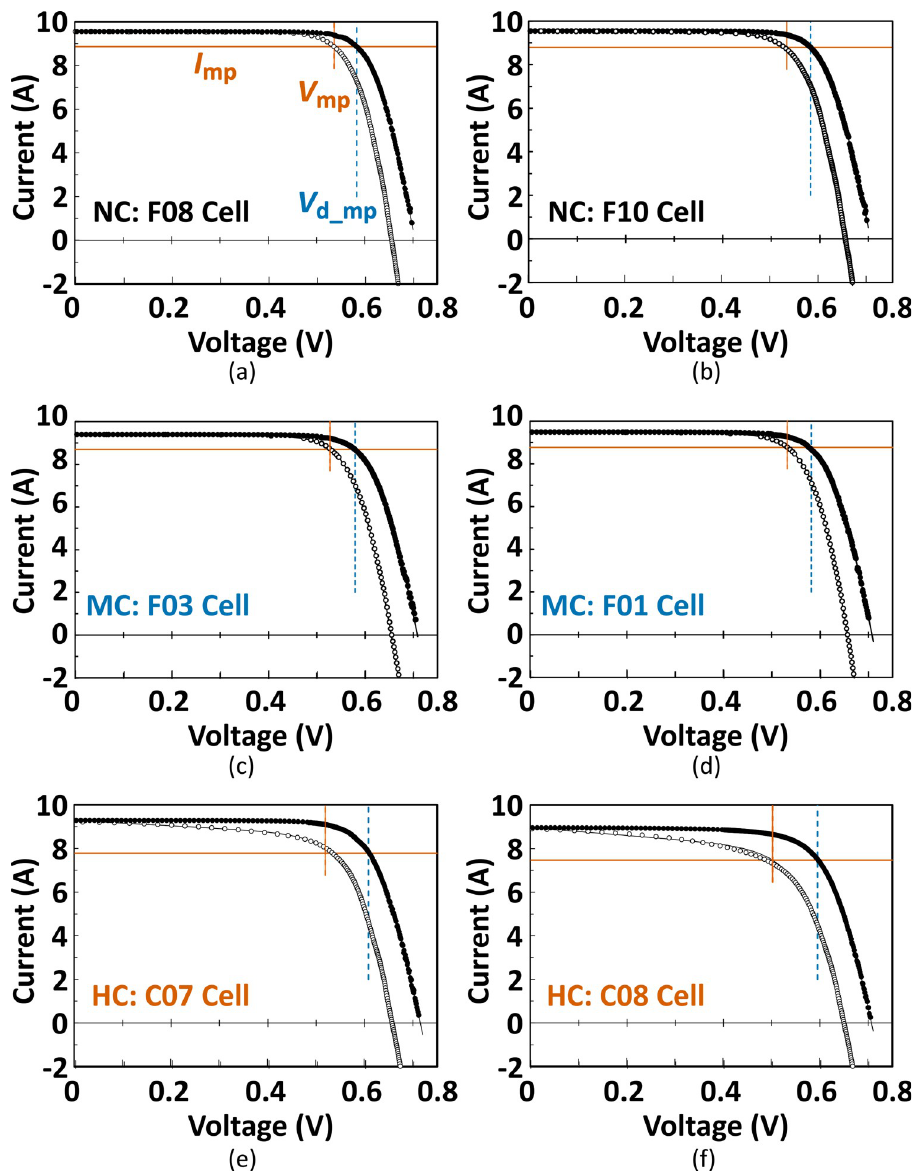
Fig 10. Flash I–V data (open circles) and overlaid “( I L - I dark ) vs. V dark ” data (closed circles) for two PV cells representing NC, MC, and HC cells. The corresponding fitted curves are indicated by black lines. The vertical orange solid-lines and blue dashed-lines denote V mp and V d-mp , respectively, for each PV cell, and the horizontal orange solid- lines also represent I mp for the respective PV